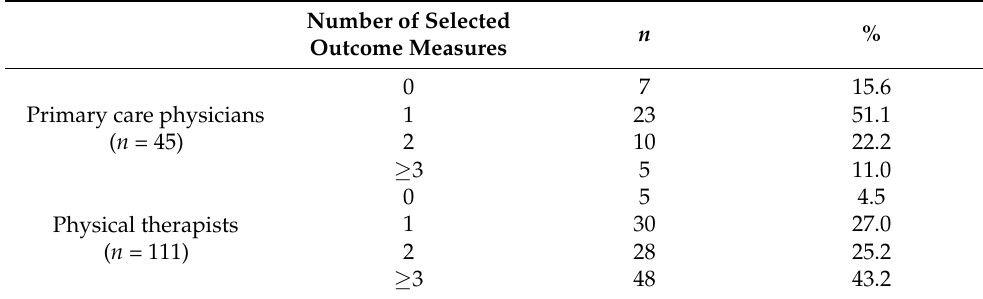
Table 2. Number of outcome measures used in clinical practice by the 111 primary care physicians and 45 physical therapist